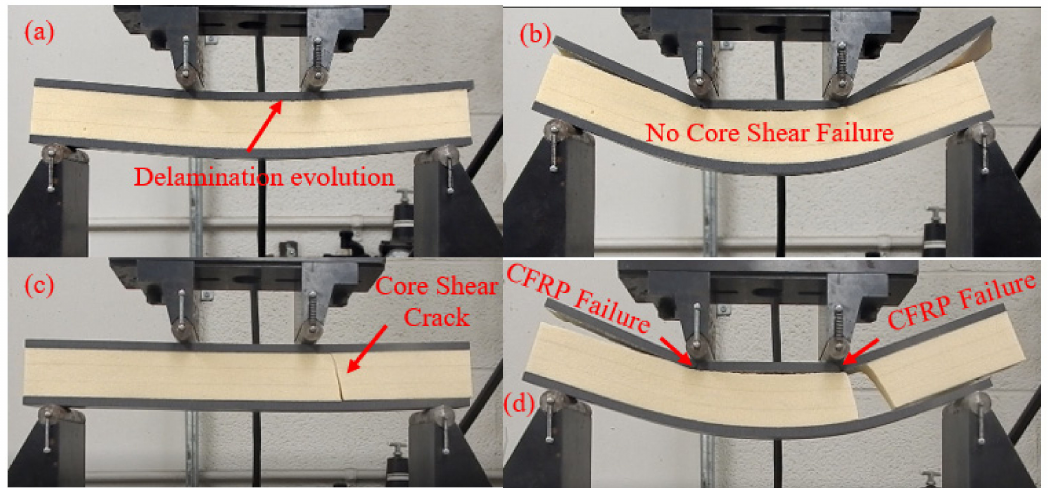
Figure 10. Damage morphologies of a CFRP / PU sandwich beam that had a thick core tested under four-point loading; ( a , b ) initial interfacial crack on the compression side; ( c , d ) initial interfacial crack on the tensile side.